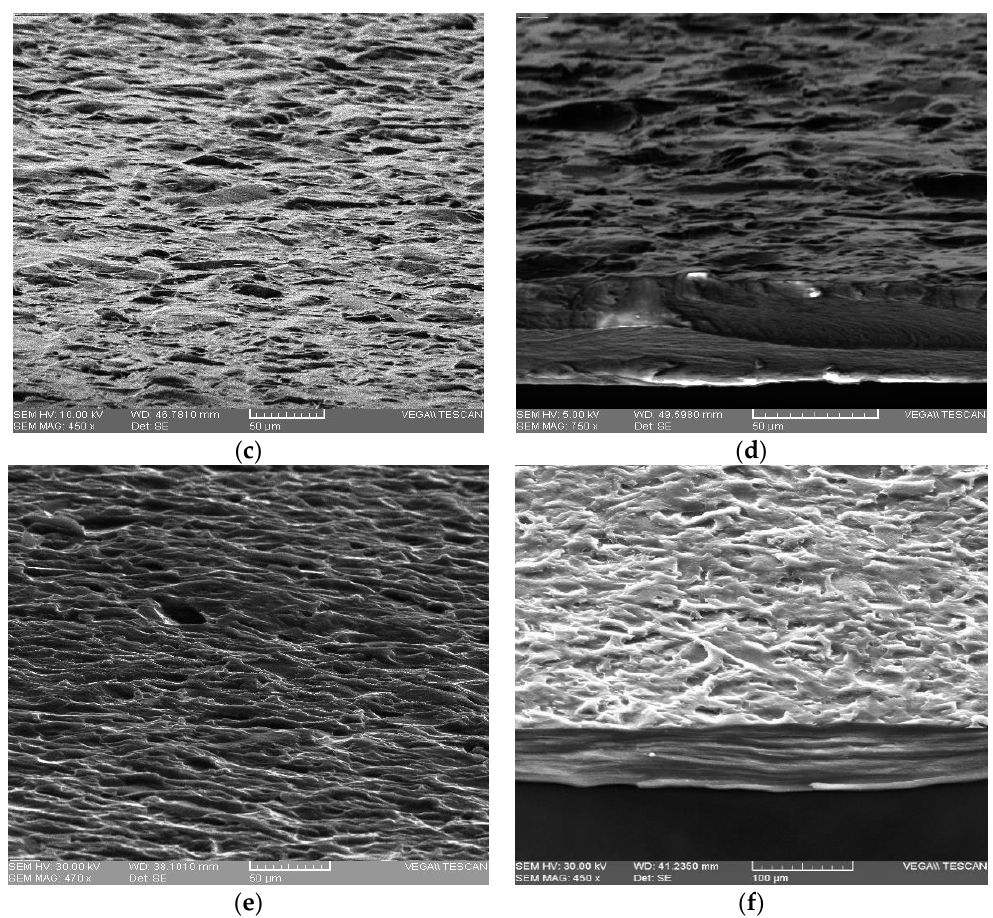
Figure 5. FE-SEM images showing surface morphologies of membranes and cross-sectional images: ( a , b ) – SAA1; ( c , d ) – SCa4; ( e , f ) – control sample-without additives .